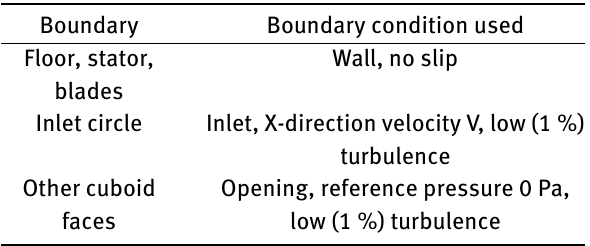
Table 1: Boundary conditions in the